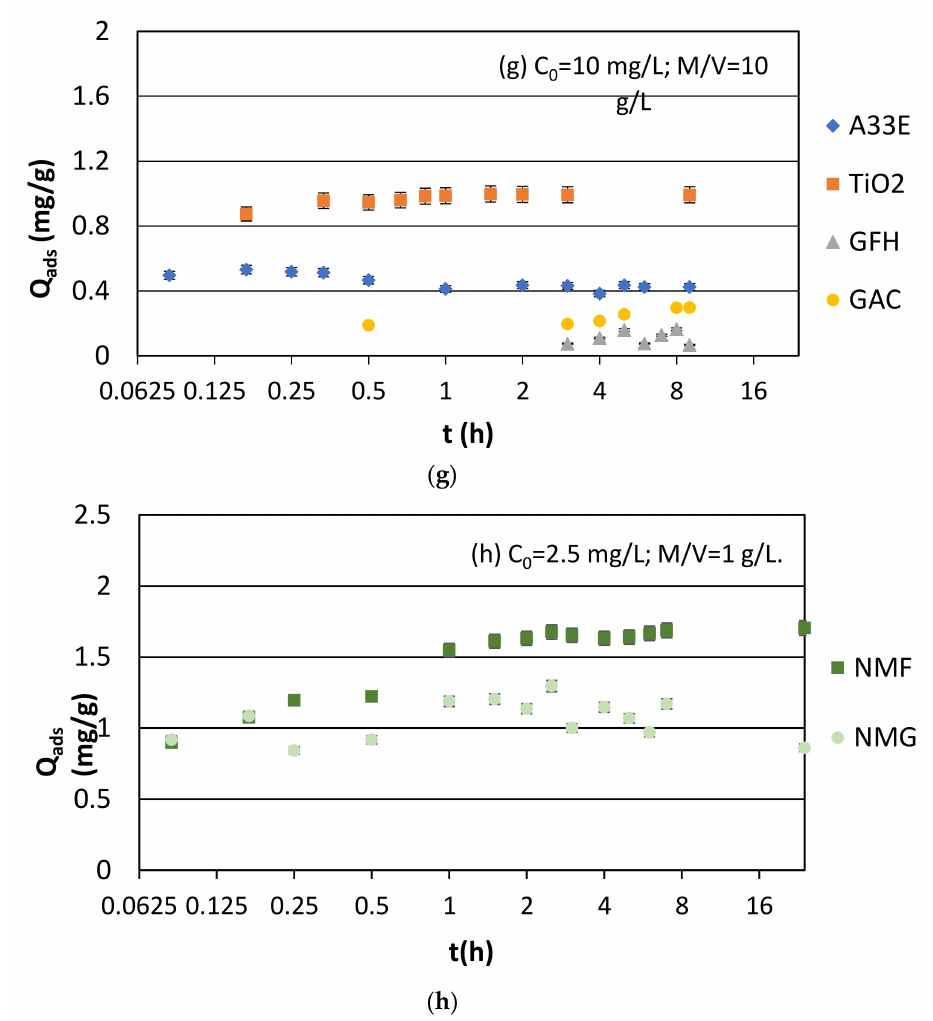
Figure 1. Adsorption capacity under uncontrolled pH for different initial fluoride concentrations and adsorbent dosages. ( a ) C 0 = 2.5 mg/L; M/V = 1 g/L; ( b ) C 0 = 2.5 mg/L; M/V = 5 g/L; ( c ) C 0 = 5 mg/L; M/V = 1 g/L; ( d ) C 0 = 5 mg/L; M/V = 5 g/L; ( e ) C 0 = 10 mg/L; M/V = 1 g/L; ( f ) C 0 = 10 mg/L; M/V = 5 g/L; ( g ) C 0 = 10 mg/L; M/V = 10 g/L; ( h ) C 0 = 2.5 mg/L; M/V = 1 g/L. Equilibrium pH: 6.6 for A33E, 5.0 for TiO 2 , 6.9 for GFH, 6.4 for GAC. The error bars indicate the standard deviation of the analytical